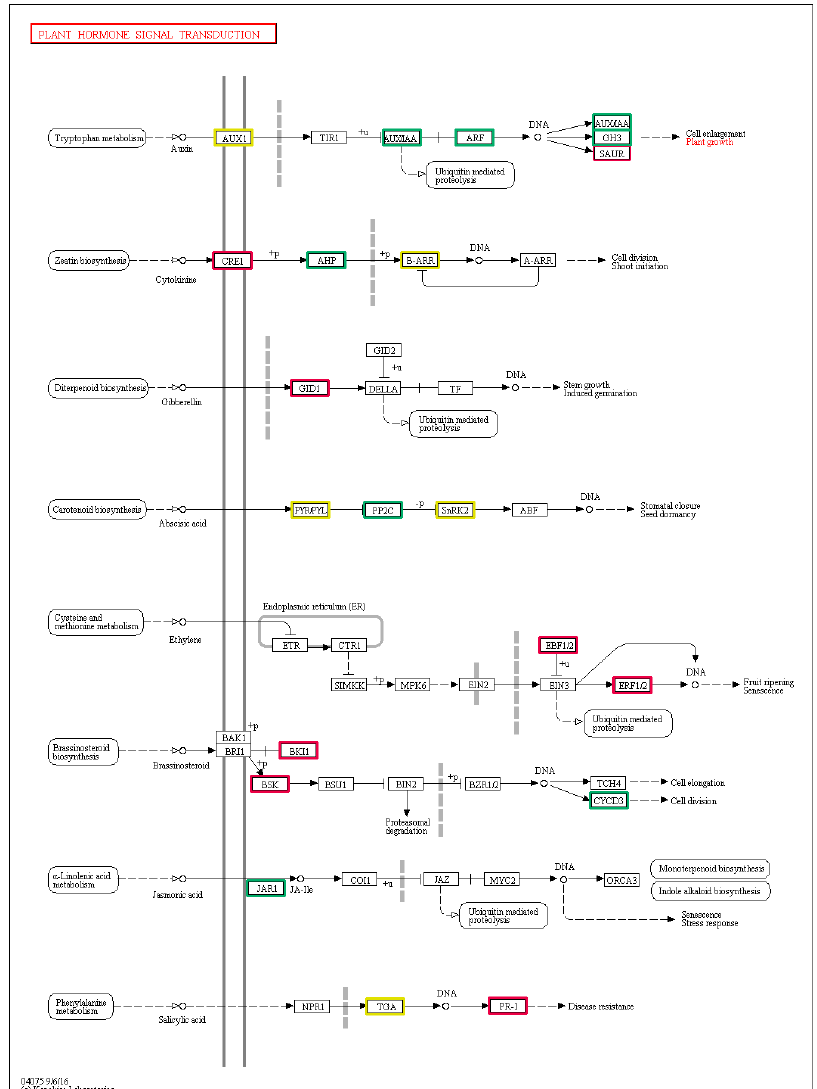
Figure 7. DEGs involved in the plant hormone signal transduction pathway. The enriched KEGG ortholog database (KO) terms are colored according to DEG regulation: red indicates up ‐ regulation, green indicates down ‐ regulation, and yellow indicates both up ‐ and down ‐ regulation.